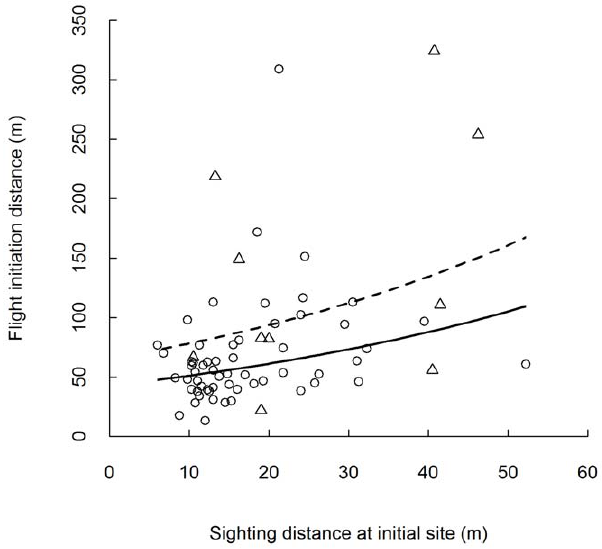
Figure 1. Flight initiation distance (FID) in relation to sighting distance at the initial site. Distribution of flight initiation distance (FID) for passive (circles and full line) and active (triangles and broken line) Scandinavian brown bears approached by humans on foot in central Sweden in 2006–2009 (n=78), in relation to sighting distance at the initial site (shorter sighting distance indicates more horizontal vegetation cover).